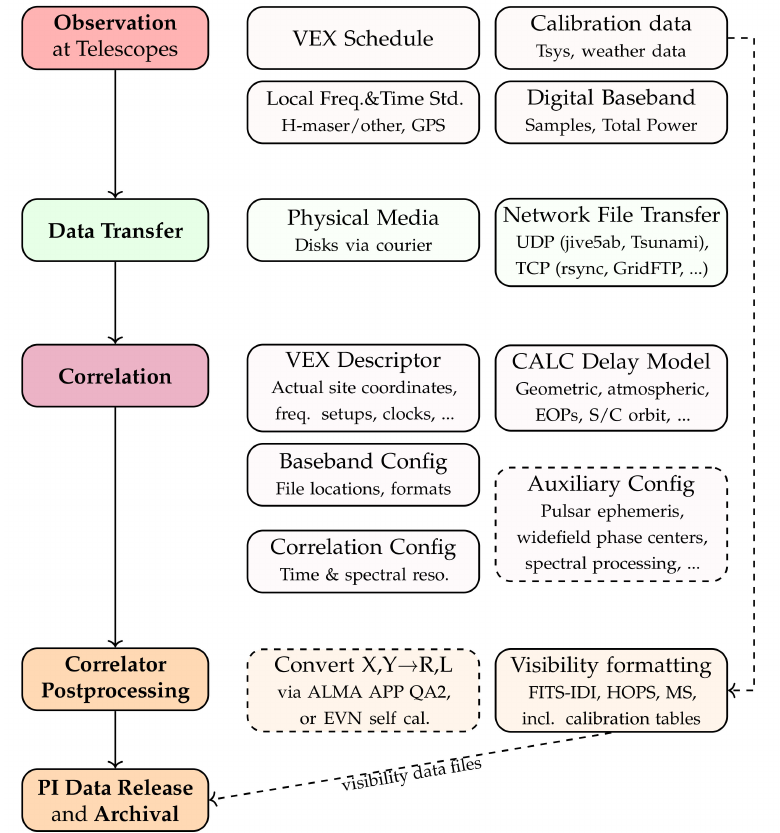
Figure 1. VLBI observation and data processing. Per-telescope baseband and calibration data are collected during VLBI observations. Calibration data are bundled with the final visibility data released to the PI. Delay models for far-field VLBI are commonly derived via NASA GSFC CALC 9/10, for near-field VLBI via c5++ or others. Dashed boxes indicate optional processing, such as pulsar processing, space VLBI antenna support, multi phase center for wide-field VLBI, spectral windowing (in SFXC ), or custom channelization (zoom bands in DiFX ). Correlation itself can run on hardware ranging from Raspberry PI and HPC clusters, to Cloud